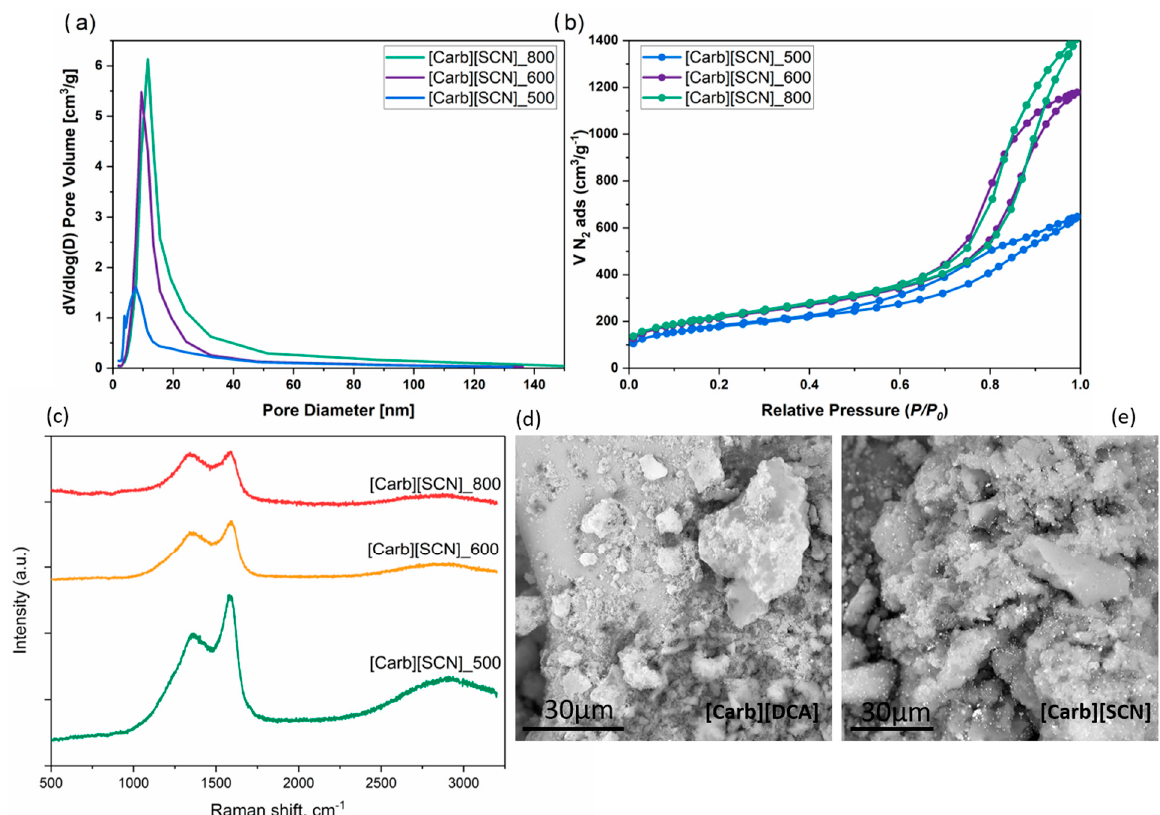
Figure 3. ( a ) Pore-size distribution and ( b ) N 2 gas adsorption/desorption isotherms for carbons derived from the precursor [Carb][SCN] at 500, 600, and 800 °C. ( c ) Raman spectra. ( d , e ) SEM images of carbon materials: [Carb][SCN], [Carb][DCA].